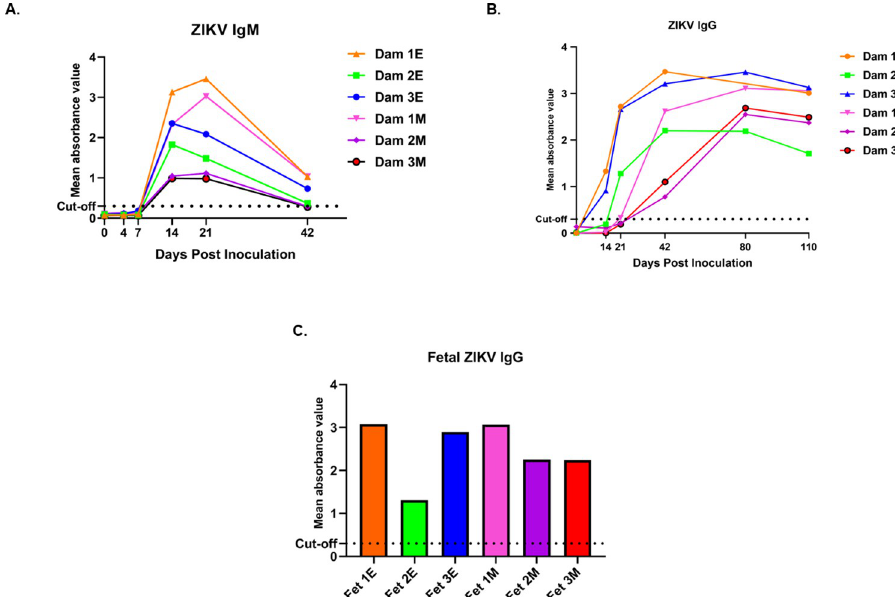
Fig 2. Detection of anti-ZIKV antibody responses in pregnant baboon serum. Antibodies against ZIKV was determined by ELISA for maternal IgM ( A ) and IgG ( B ) and fetal IgG ( C ). anti-ZIKV IgM were detected at 14 days post-inoculation in all six baboons sampled at this time point. In the early-gestation group, dams 1E and 3E had ZIKV IgG at 14 dpi and dam 2E had at 21 dpi. In the mid-gestation inoculation group, all three dams had IgG by 21dpi. All six fetuses had anti-ZIKV IgG at levels similar to the mothers indicating efficient Fc γ R transfer of IgG across the placenta. Mean absorbance value was calculated from duplicates for each sample. Absorbance for all serum samples was read at 450nm for IgM and 405nm for ZIKV IgG assays. Cut off values for both assays were set per manufacturer’s criteria for each